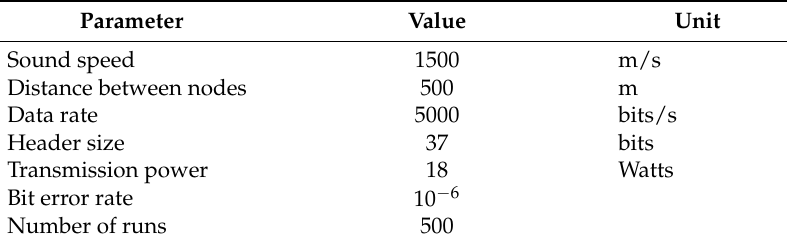
Table 3. Simulation